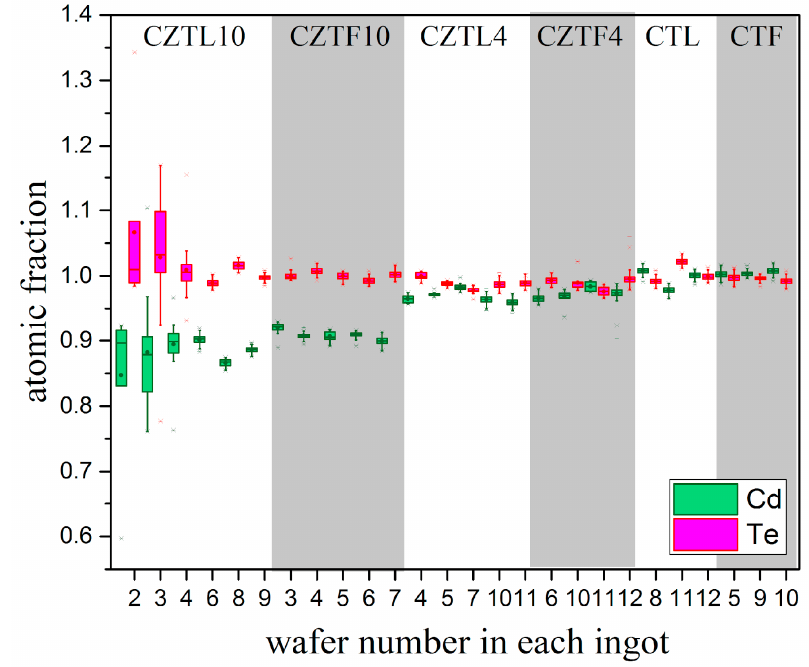
Figure 8. Cd and Te atomic fraction in wafers of all grown ingots. The total number “n” measurements (population) were on average around 80 for each wafer.